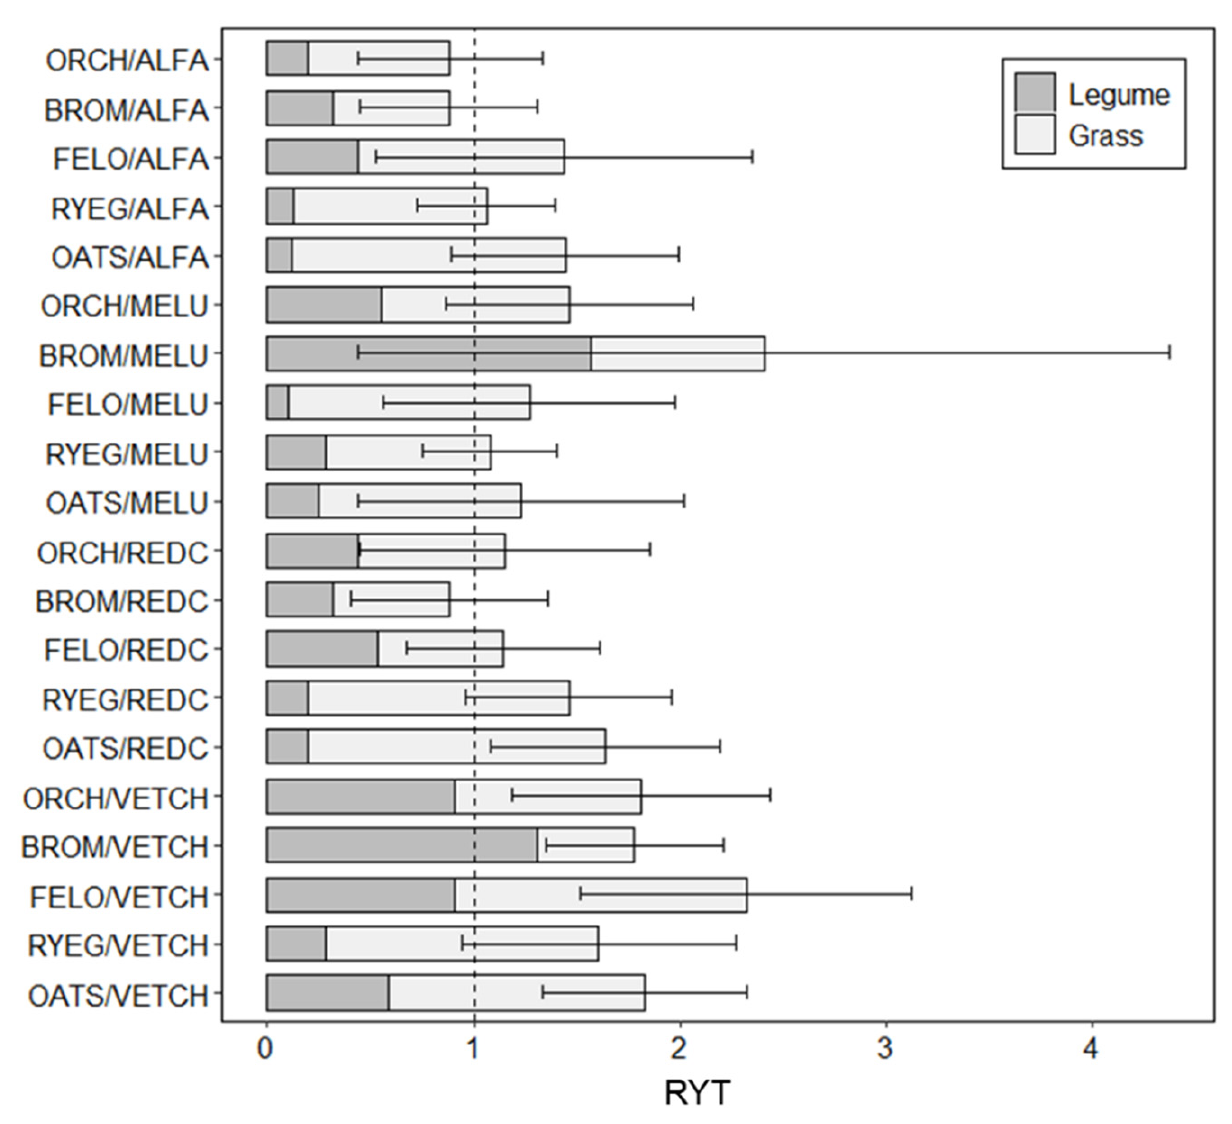
Figure 3. Relative Yield Total (RYT) for different grass–legume biculture treatments, corresponding to the total biomass and averaged across soil types. Errors bars represent 95% of the confidence interval for the estimated averages, and the values greater than 1.0 indicate bicultures that are more productive than the monocultures of their component species.